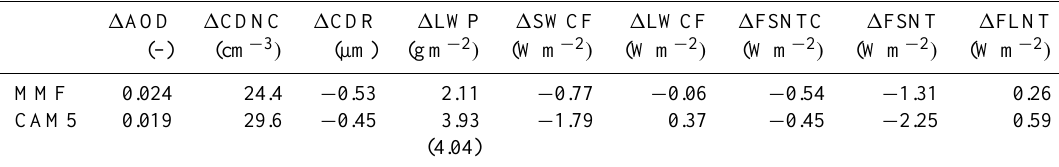
Table 5. Changes in global annual mean cloud and radiative parameters between the PI and PD simulations (PD–PI) in both the MMF and CAM5: aerosol optical depth (AOD), cloud-top droplet number concentrations (CDNC), cloud-top droplet effective radius (CDR), liquid water path (LWP), shortwave (SWCF) and longwave (LWCF) cloud forcing, clear-sky (FSNTC) and whole-sky (FSNT) shortwave radiative fluxes at the top of the atmosphere, and whole-sky longwave radiative flux (FLNT) at the top of the atmosphere. For LWP from CAM5, the change in LWP from large-scale clouds is in